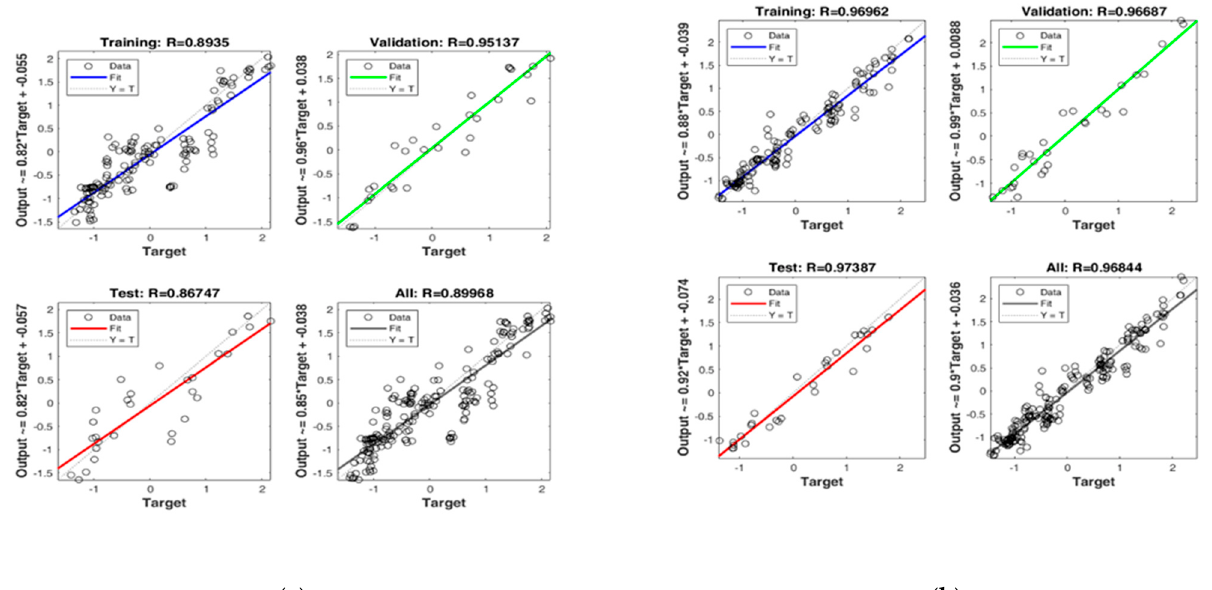
Figure 9. Regression coefficients before and after ANN optimization ( a ) Regression coefficients before ANN optimization; ( b ) Regression coefficients after ANN optimization.